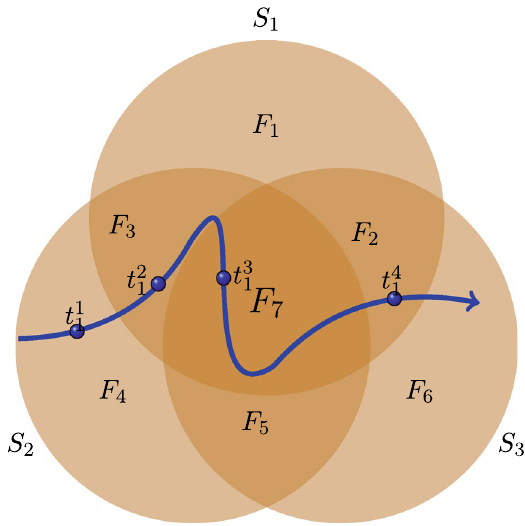
Fig. 3 Interest area and target